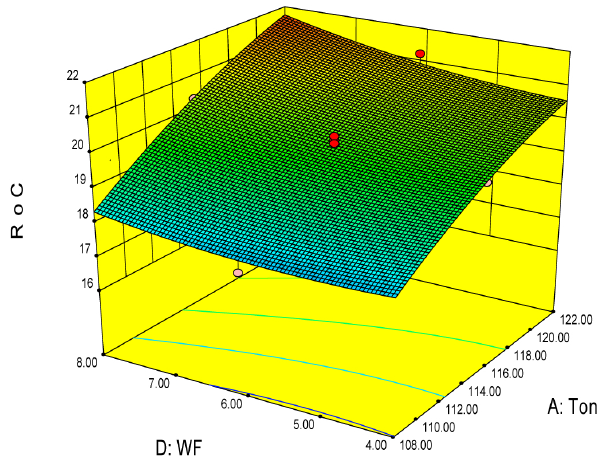
Figure 8c. Combined e ff ects of T on and WF on RoC.